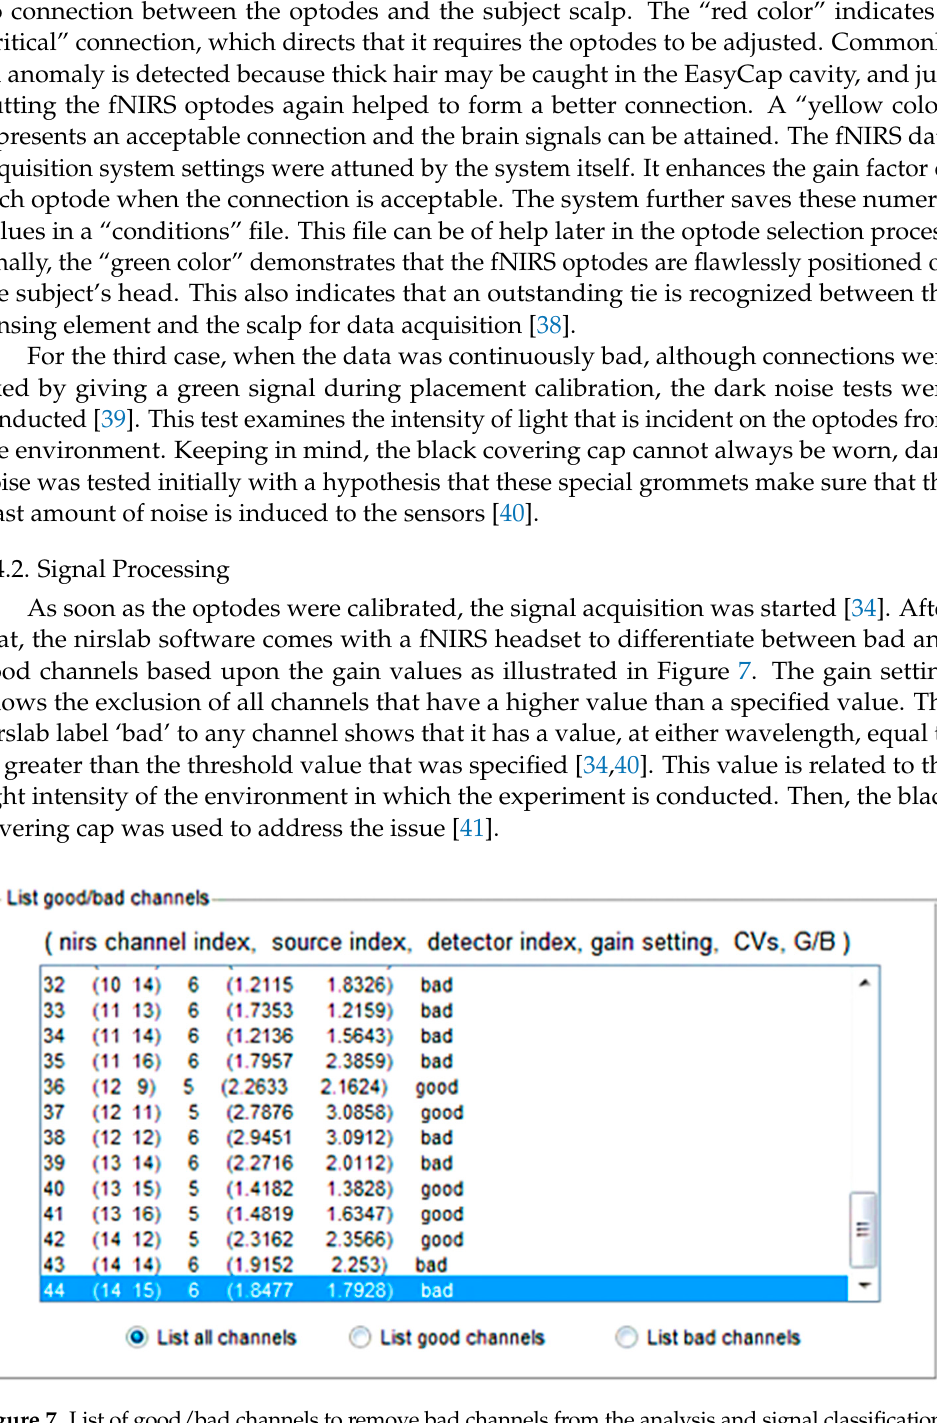
Figure 8. Visualization of recorded raw light intensity of each optode.